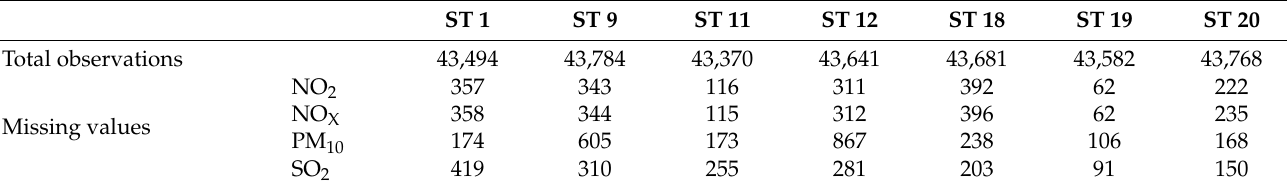
Table 2. Total observations and missing values.